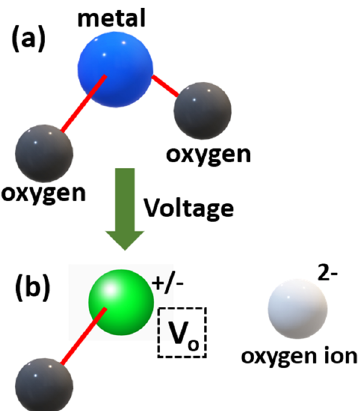
Figure 16: Schematic of oxygen vacancy ( V o ) formation by producing either positively or negatively fi xed/immobile charged and nega - tively charged oxygen ions after the metal oxide absorbed energy from the applied